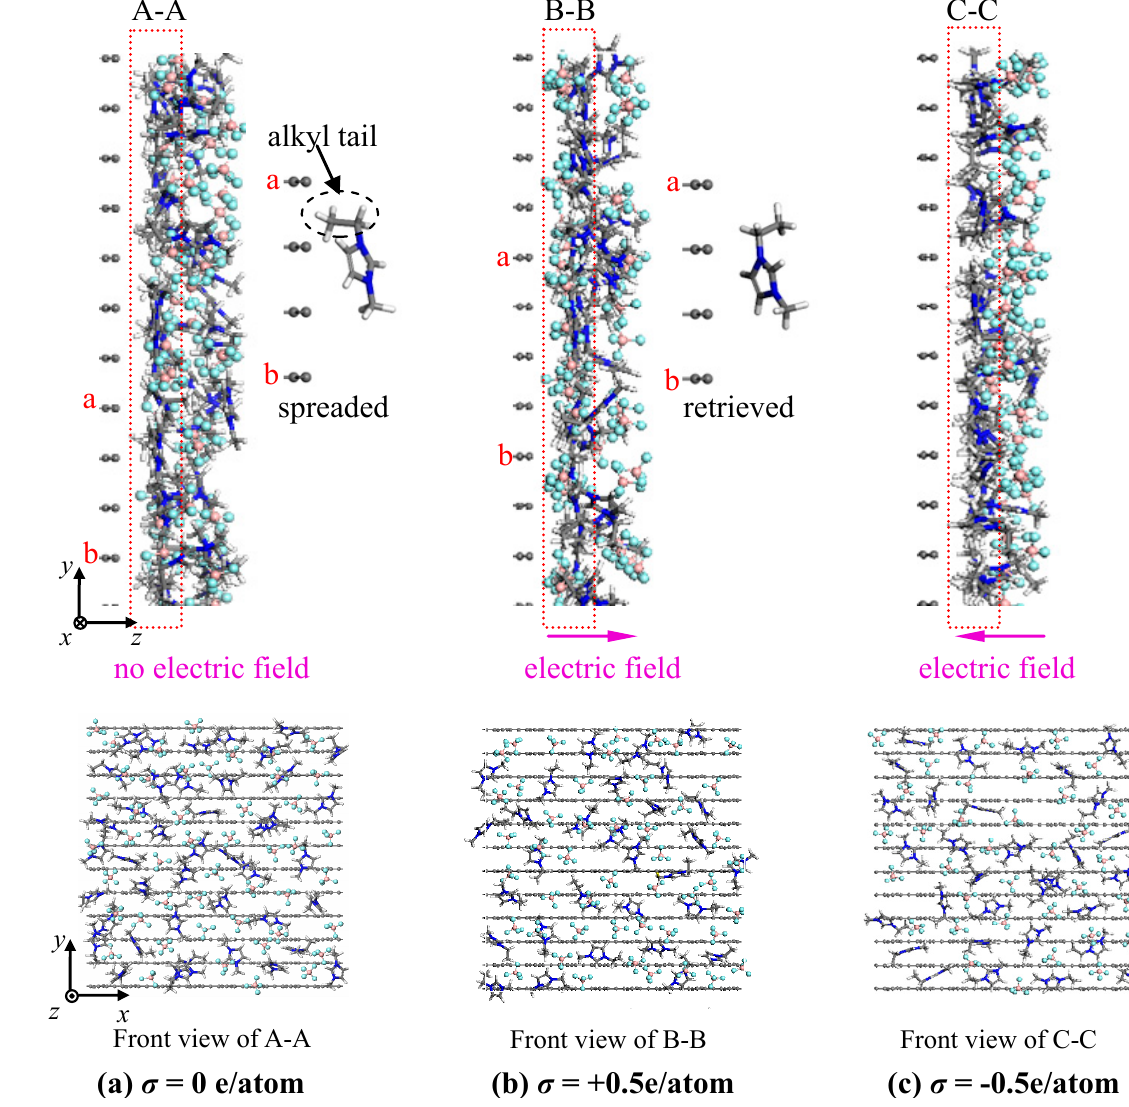
Figure 2. Snapshots of ions in the layer close to the non-rough electrode surface with different charges: ( a ) σ = 0 e/atom, ( b ) σ = +0.5 e/atom, ( c ) σ = − 0.5 e/atom.